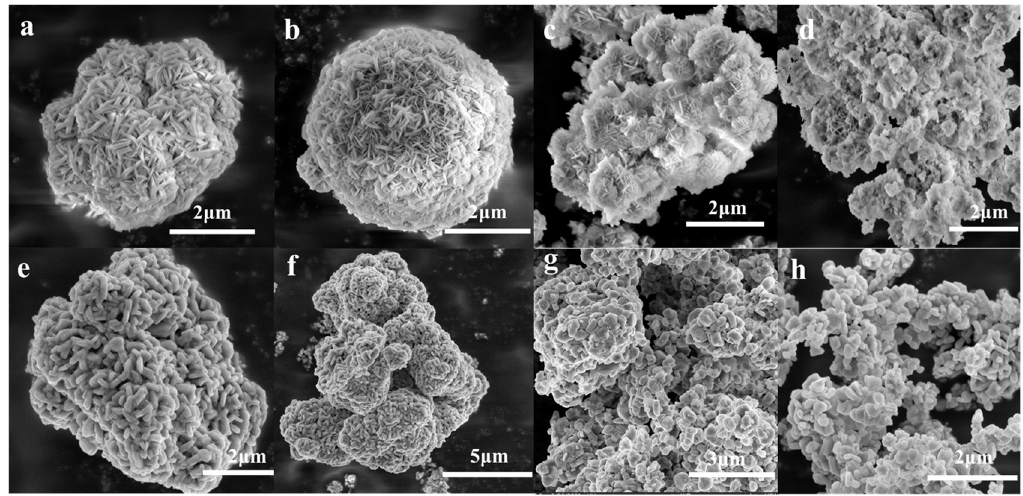
Figure 3. SEM images of precursor different ammonia content ( a ) AC:70 mL. ( b ) AC:60 mL. ( c ) AC:50 mL. ( d ) AC:40 mL. SEM images of NCM622 different ammonia content ( e ) AC:70 mL. ( f ) AC:60 mL. ( g ) AC:50 mL. ( h ) AC:40 mL.